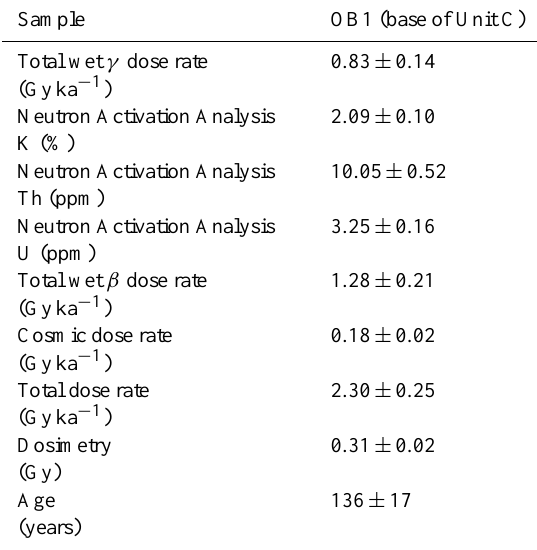
Table 1. OSL results obtained for unit C from Lagoa de ´Obidos (please note that the data of core collection was